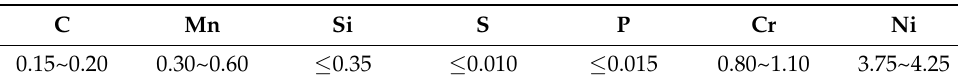
Table 2. Chemical composition of 18CrNi4A.